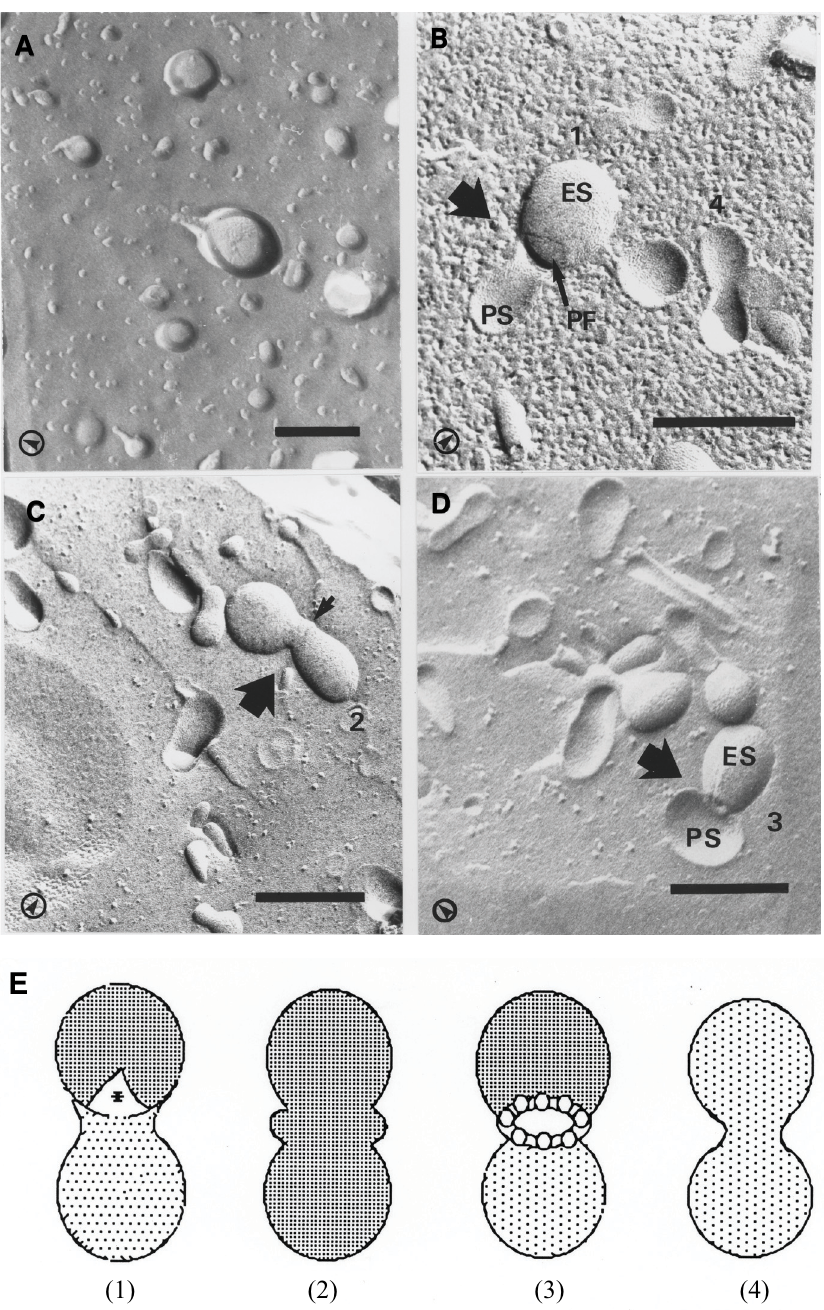
Figure 1. Fusion events in a model liposome dispersion induced by glycerin. Various stages of liposome-liposome fusion event were captured by rapid freezing. A ) Liposomes were freeze-fractured without the addition of glycerol. B–D ) Liposomes were preincubated with 30% v/v for 30 minutes before freezing. B ) The first stage of liposome-liposome fusion: the joining of the outer monolayers of the liposomes (large arrow) is apparent without communication between their internal spaces. C ) Early liposome-liposome fusion intermediate (large arrow) fractured at the exterior surface of the membrane. The rim between the two vesicles (small arrow) is indicative of non-bilayer intermediate structures. D ) Late liposome-liposome fusion intermediate (large arrow). One of the liposomes was fractured on the external surface, the other on the internal surface with its internal space is being visible and exposing the fusion interface. The presence of small (10–12 nm) particles can be distinguished at the fusion rim. E ) Schematic representation of the identified fusion intermediates. Numbers on micrographs correspond to the numbers of the diagrams. Freeze-fracture nomenclature 27 : ES - external surface; PS - cytoplasmic surface (in this case interior surface of liposome); PF and * - fractured face of the lipid monolayer adjacent to the interior space of the vesicle; arrows in left corners of micrographs indicate the shadowing direction. Bars 250